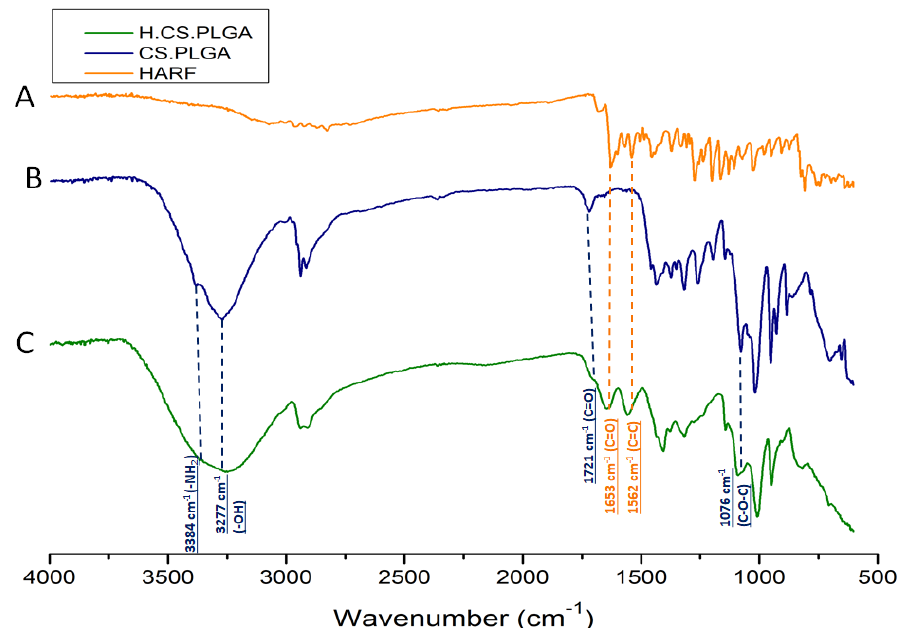
Figure 3. ATR-FTIR spectra of HARF ( A ), blank formulation (CS/PLGA NPs; ( B )), and optimized H/CS/PLGA NPs formulation ( C ).